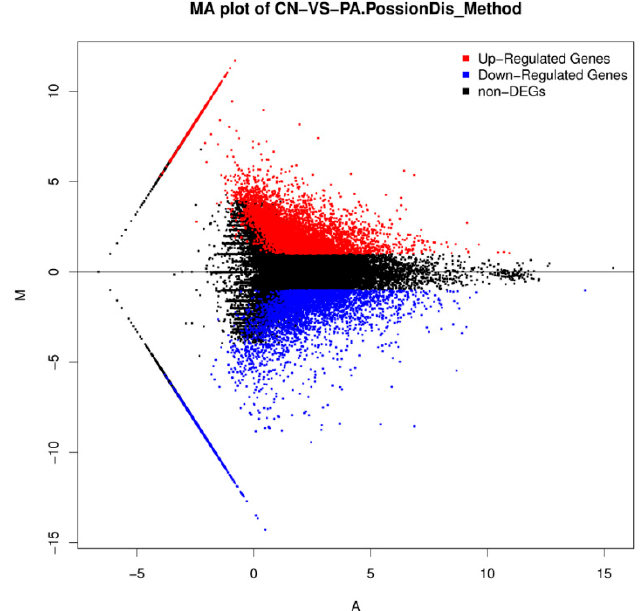
Figure 4. M (log ratio) and A (mean average) (MA) plot of DEGs between the control (CN) and the PA-treated group. The x -axis represents value A (log2 mean expression level). The y-axis represents value M (log2 transformed fold change). Blue, red, and black points represent down regulated genes, up regulated genes and non-differential expression genes, respectively.